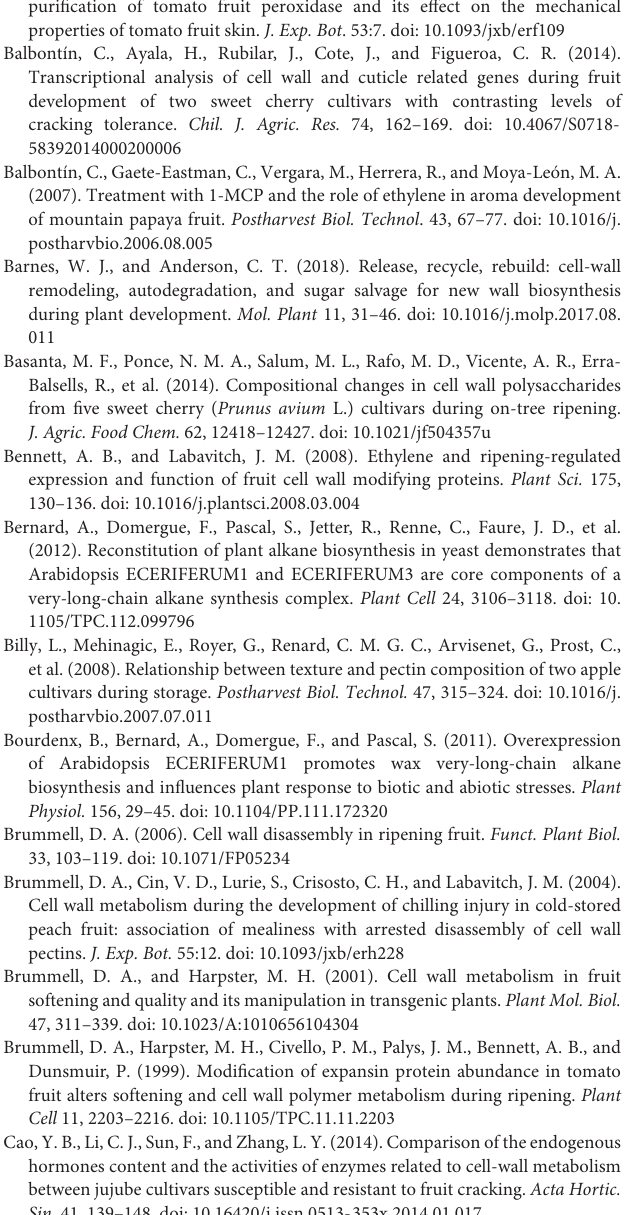
Supplementary Figure 4 | Co-expression network between the candidate structural genes and transcription factors and the qPCR results of the six ethylene signal transduction genes. Co-expression networks between differentially expressed structural genes in the cell wall modification pathway and differentially expressed transcription factors (TFs) at 96 and 141 DASP. Dark green circles represent PMEs, yellow circles represent β -Glus, brown circles represent PLs, blue circles represent PGs, bright green circles represent PODs, and pink circles represent EXPs.